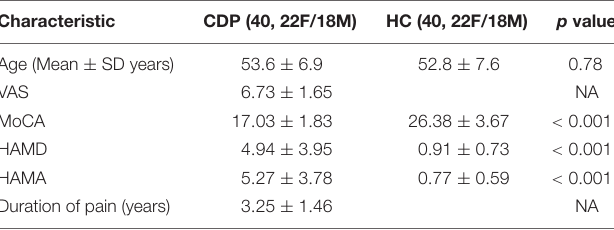
TABLE 1 | Demographic characteristics of cervical discogenic pain (CDP) and healthy controls (HC). Characteristic